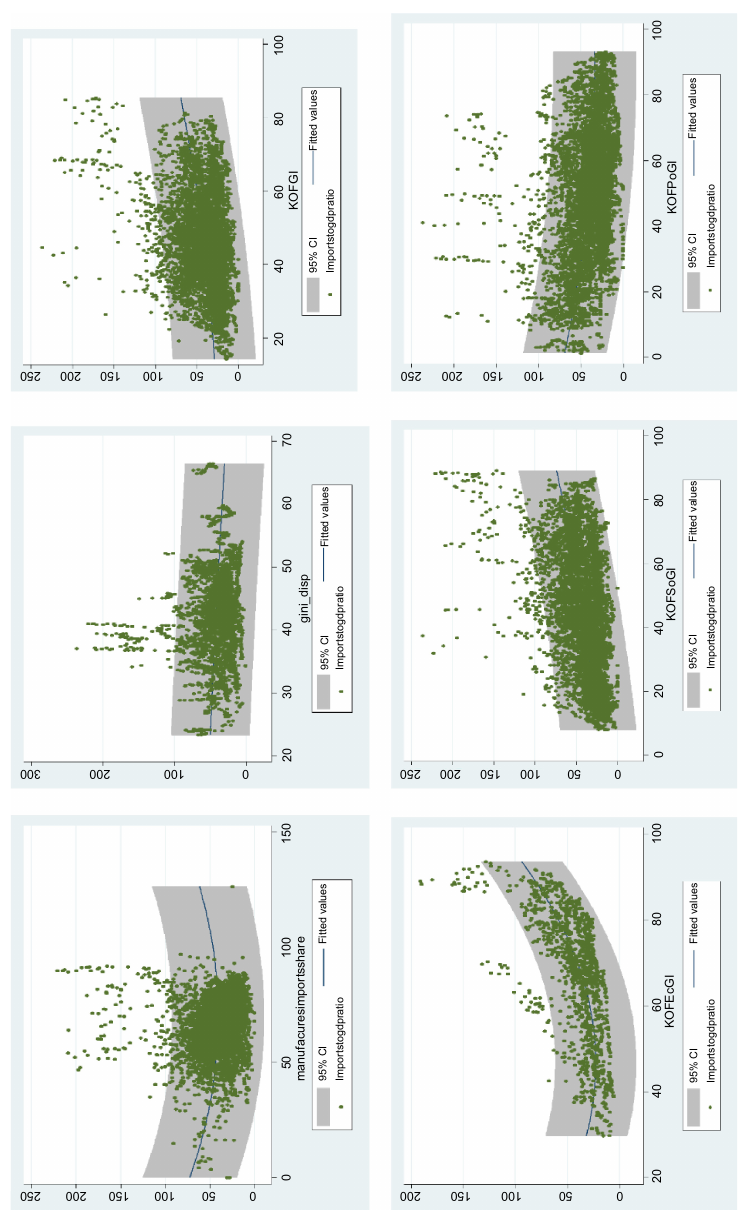
Figure 9. Scatter plots and OLS fitted (developing